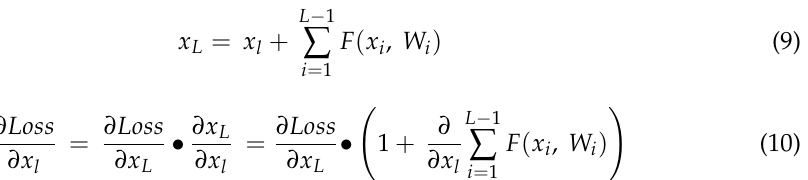
Figure 6. Operation declaration of the residual connection in a deep neural network.